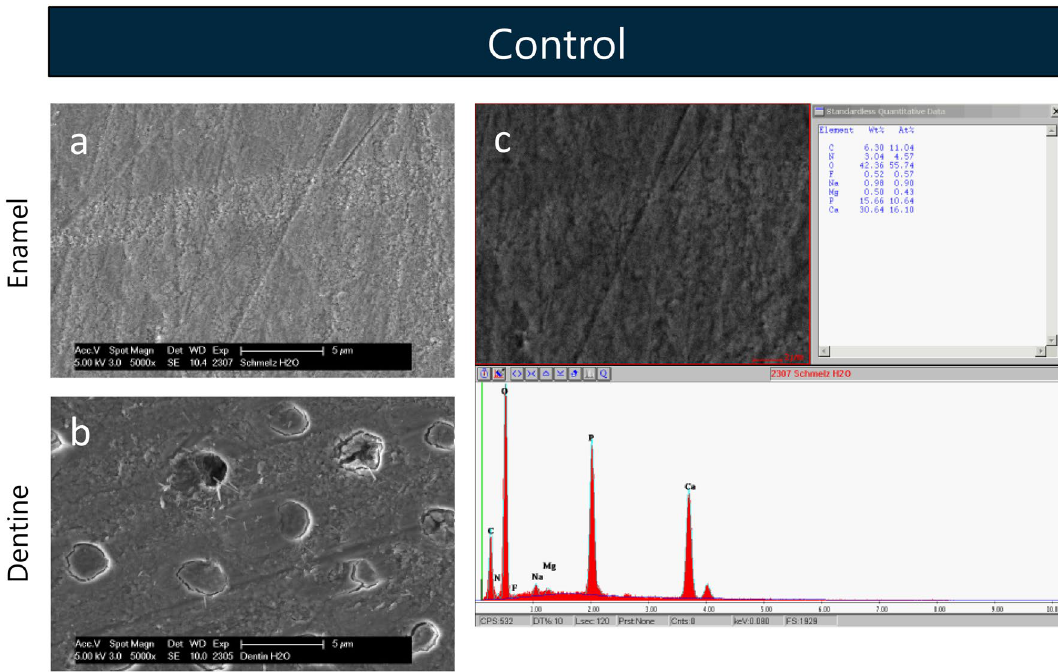
Figure 2. SEM figures at 5000-fold magnification of enamel ( a ) and dentine ( b ) samples and exemplaric EDX analysis of a enamel sample ( c ) after 5 min incubation in distilled water. The images reveal a polished enamel and dentine surface without any